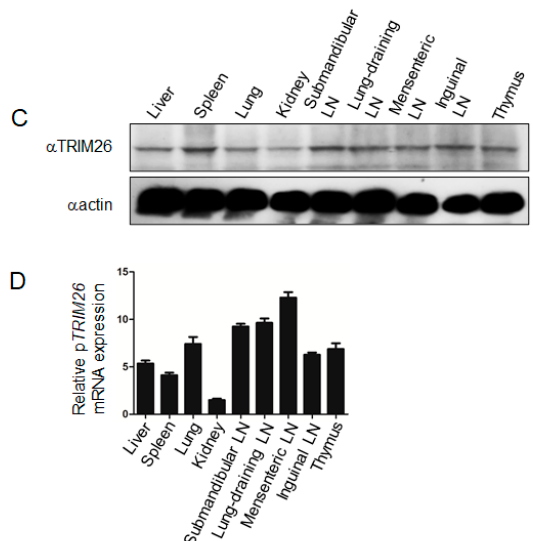
Figure 2. ( A ) Specificity of polyclonal antibody against porcine TRIM26 was analyzed with Western blotting. ( B ) Expression profiles of TRIM26 in di ff erent porcine cell lines, analyzed with Western blotting with anti-TRIM26 antibody. ( C ) Expression profiles of TRIM26 in di ff erent pig tissues ( n = 3), analyzed with Western blotting and an anti-TRIM26 polyclonal antibody. Approximately 100 mg of each tissue was homogenized with lysis bu ff er as per the Materials and Method section for protein sample preparation. ( D ) Expression profiles of TRIM26 in di ff erent pig tissues ( n = 3) analyzed by reverse transcription-quantitative PCR.